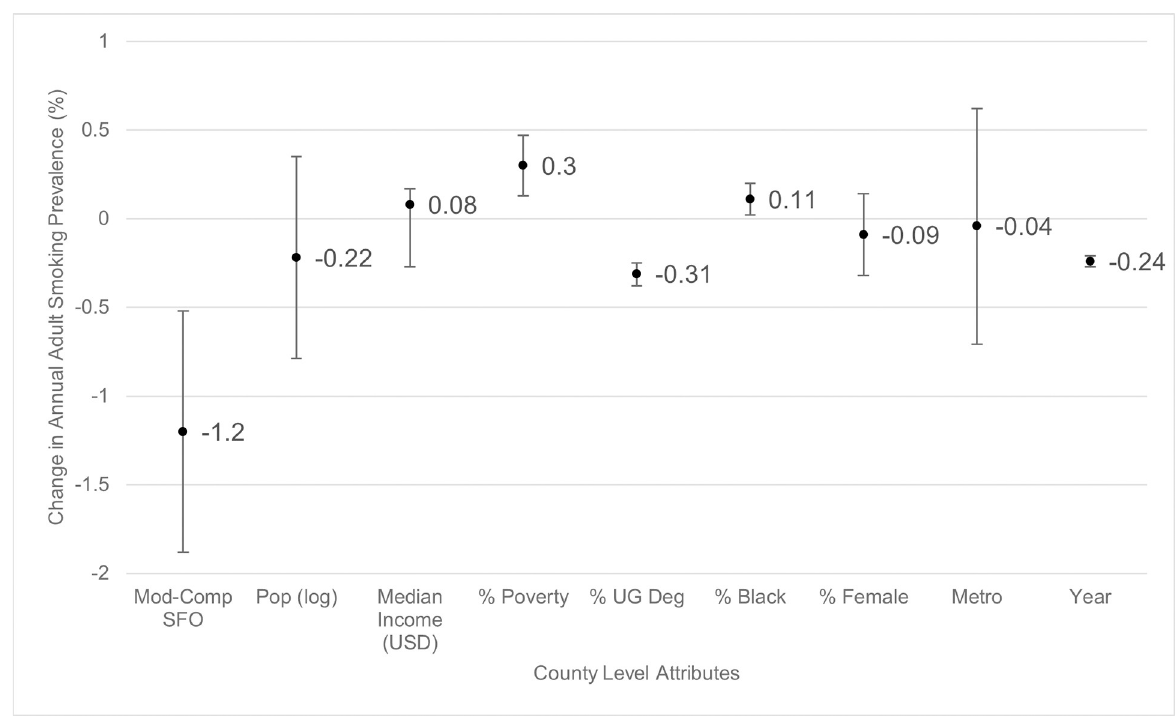
Fig 3. Change in smoking prevalence by county-level attributes. Mod-Comp SFO = moderate-to-comprehensive smoke-free ordinance, pop (log) = population log, % UG Deg = percent with undergraduate degree. Circles represent estimated change in smoking prevalence and bars represent 95% confidence intervals. “Moderate to comprehensive smoke-free ordinances” change is calculated relative to none or weak smoke-free ordinance counties. “Population (log)” change is calculated based on each 10% increase in population. For continuous predictor values, circles represent estimated change based on 1% increase in corresponding characteristic (e.g., for each 1% in poverty, the smoking prevalence increases by 0.3%) except for “Median Income (USD)” which is estimated as change based on an increase of $1,000 and “year,” for which change is estimated based on an increase of 1 year. For “metro”, change is calculated as counties classified as metropolitan versus rural.